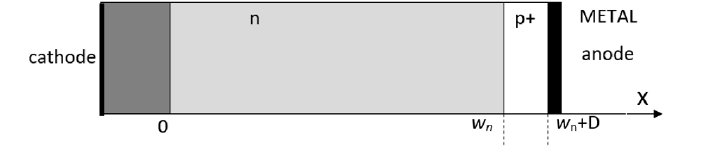
Figure 1. Schematic description of double barrier structure.